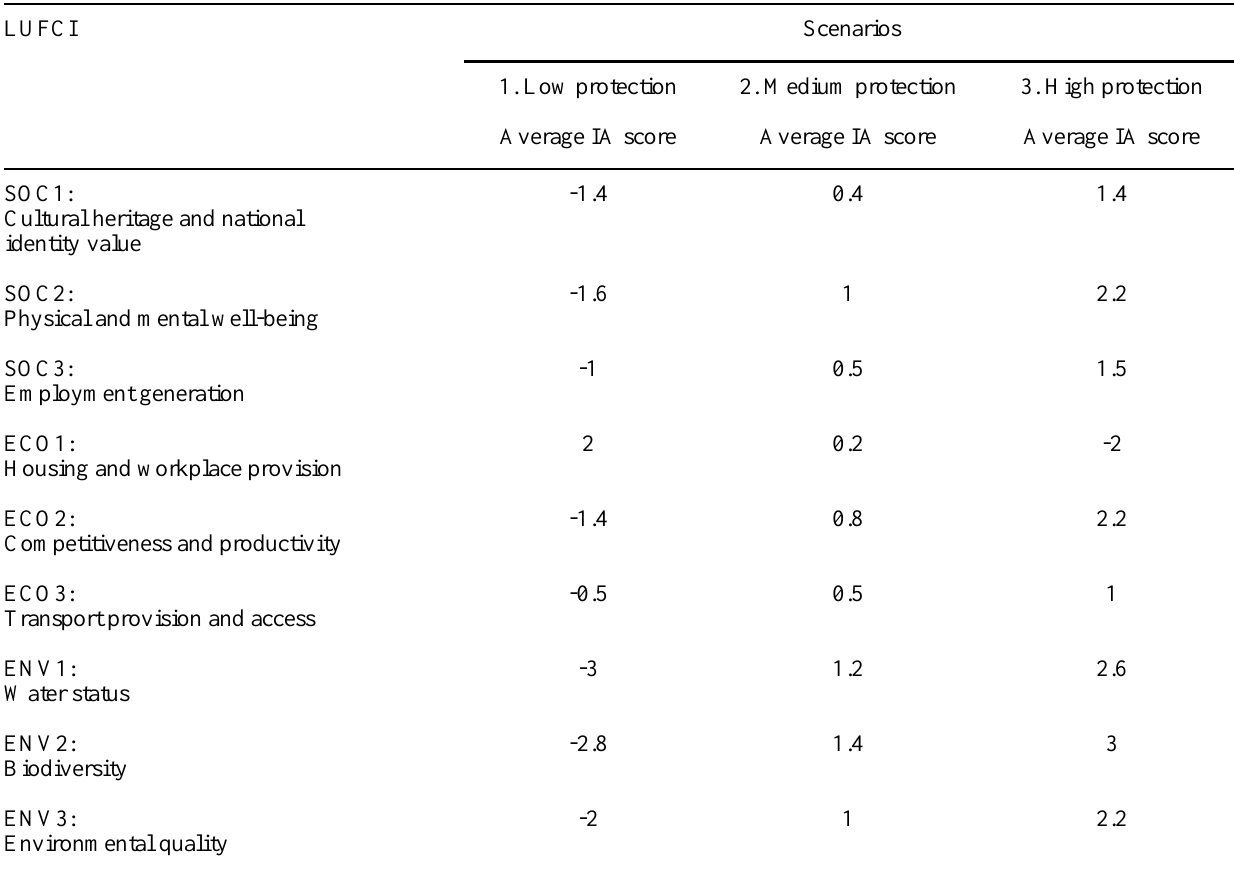
Table 4 . Definition of LUFCI in Malta